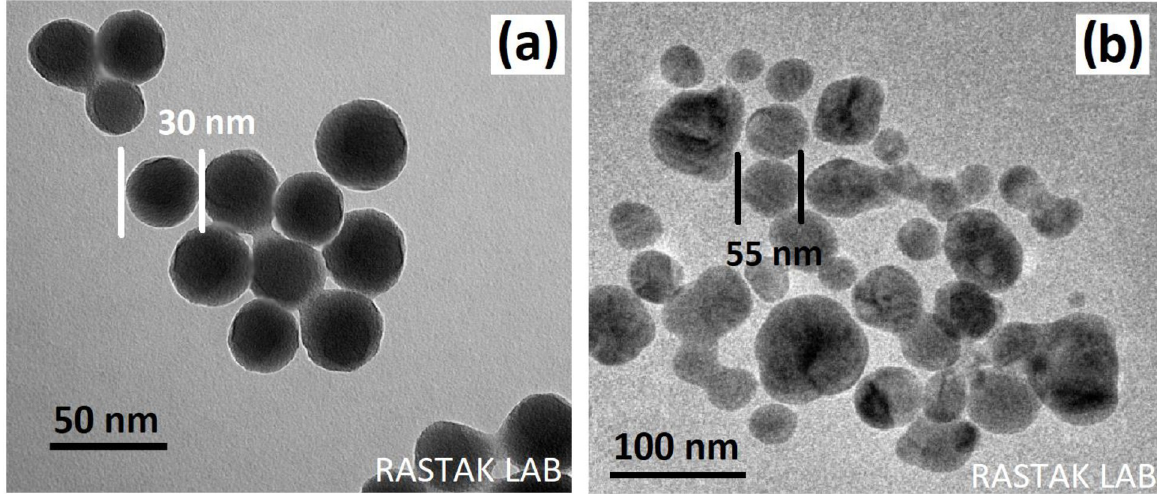
Fig 7. TEM images of (a) CS-SiO 2 NPs and (b) GS-SiO 2 NPs.